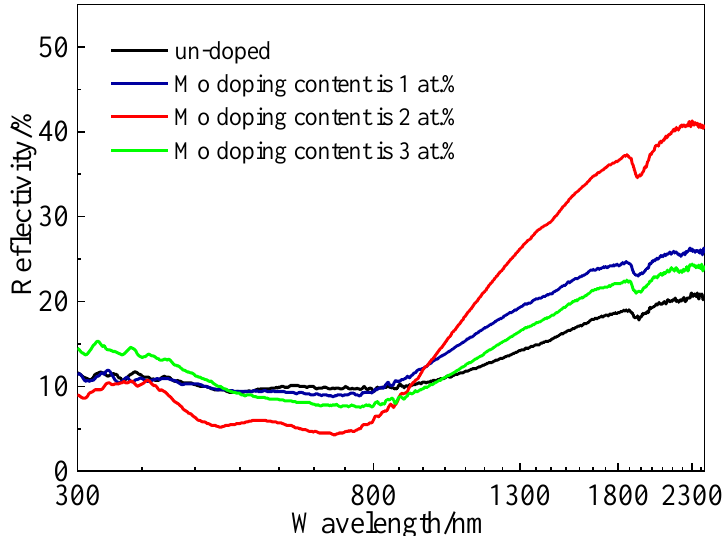
Figure 12. Reflectivity variation with Mo content after thermal oxidation in atmosphere at 500 °C for 8 h (Al content is 10 at.%). 8 h (Al content is 10